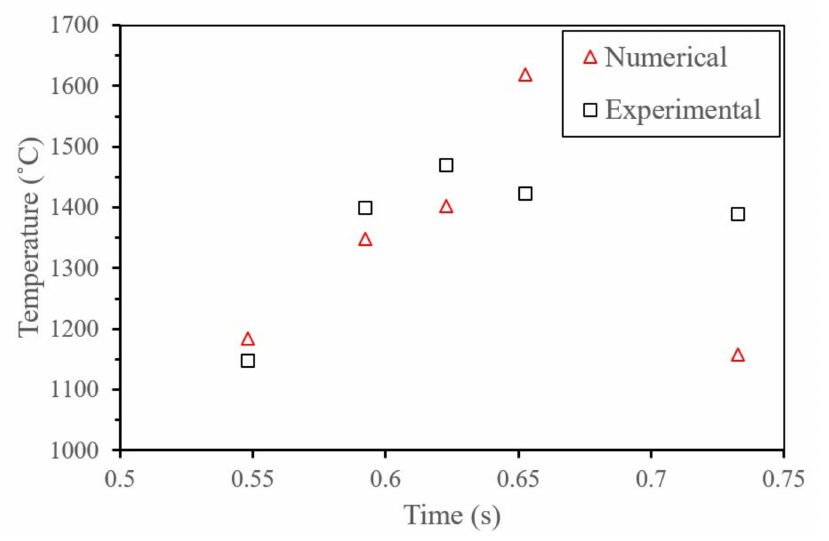
Figure 14. Experimental vs. numerical temperature measurement. The temperature history is plotted at three points, 1 mm apart, at 220 W laser power, 650 mm/s scan speed, and 0.12 mm hatch spacing, as shown in Figure 15. The three points exhibit the same thermal cycles where the temperature rises to a point shy of the melting temperature as the laser scans the precedent track. Afterward, the temperature at the point of interest cools down to about 500 ◦ C as the laser beam passes directly over it, resulting in a peak temperature higher than the boiling temperature. Due to rapid cooling, the temperature drops from 2900 ◦ C down to 570 ◦ C, where the heat from the subsequent track scan causes the temperature to rise again to 950 ◦ C. Beyond that point, the temperature drops to a plateau of about 650 ◦ C until the whole layer is scanned. The CR and temperature gradients are plotted in Figure 16 for the points mentioned above. The presented CR is calculated as the temperature cools down below 1000 ◦ C. Although a larger surrounding solid area could indicate that the cooling will increase because the solid material has higher thermal conductivity and specific heat capacity compared to the powder state, it is shown that the CR decreases as the area of the solidified layer increases. The reason is that the larger solidified volume retains more heat; therefore, the area surrounding the melt pool has a relatively high temperature, resulting in a lower temperature gradient, as shown in Figure 16, and lower heat transfer due to